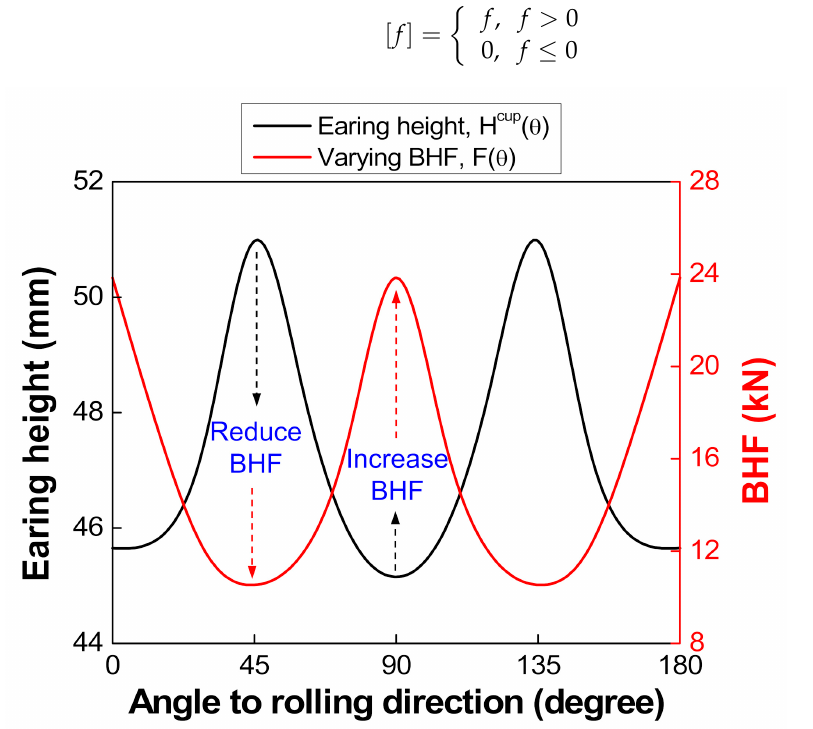
Figure 3. The variation of the BHF, F ( θ ), corresponding to the variation of earing height, H cup ( θ ), where the BHF tends to reduce in the earing regions and increase in the valley regions.